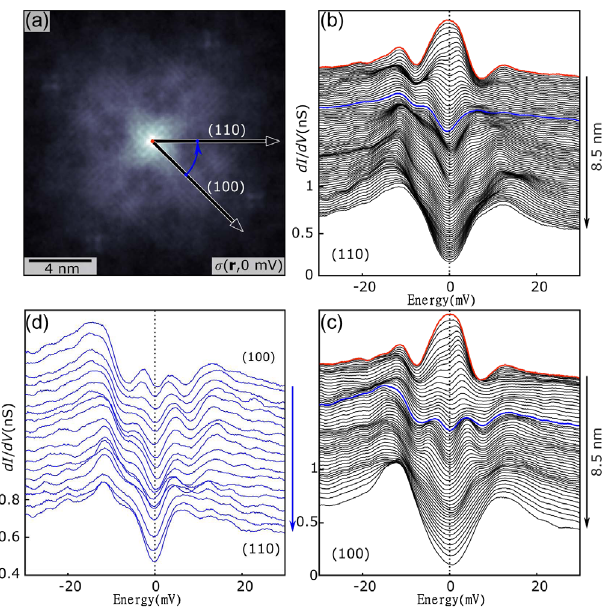
FIG. 4. Angular dependence of the low-field vortex-core structure at 0.16 Tesla. (a) Four-quadrant averaged STS con- ductance map σ ð r ; 0 mV Þ of vortex 2 in Fig. 3. (b) Differential tunneling conductance spectra along the (110) crystallographic direction in panel (a). (c) Differential tunneling conductance spectra along the (100) crystallographic direction in panel (a). (d) Differential tunneling conductance spectra along the arc from (100) to (110) depicted in panel (a). All the spectra are four- quadrant averaged. Conductance scales correspond to bottom spectra in panels (b) – (d); other spectra are offset for